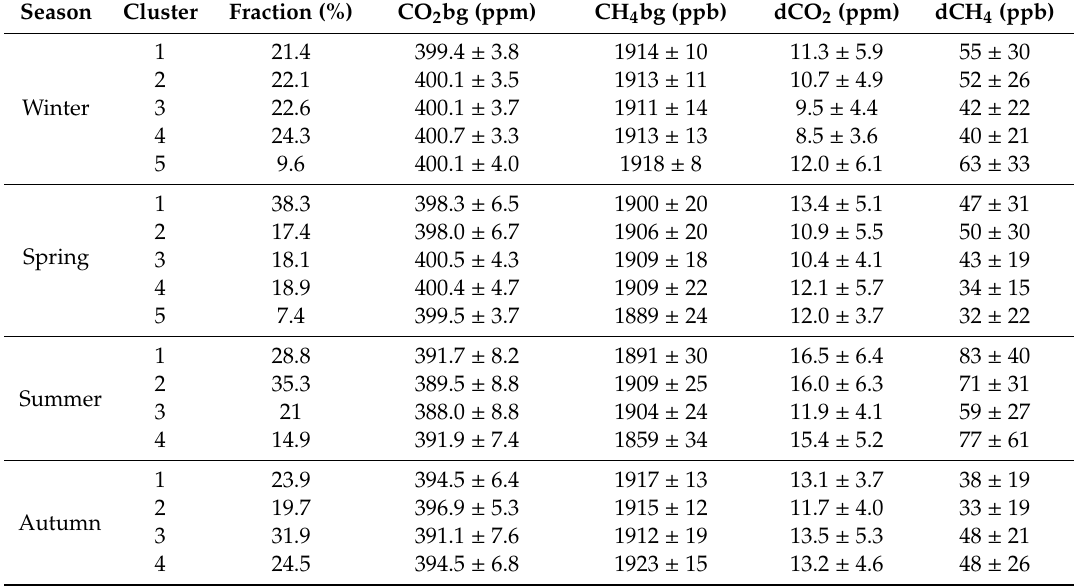
Table 2. Seasonal mean trajectory clusters and associated mean delta concentrations for CO 2 and CH 4 (i.e., dCO 2 and dCH 4 ). The delta concentrations are equal to the polluted concentration minus the background concentrations (e.g., dCO 2 = CO 2 pol − CO 2 bg). The percentage of air masses from each cluster is in